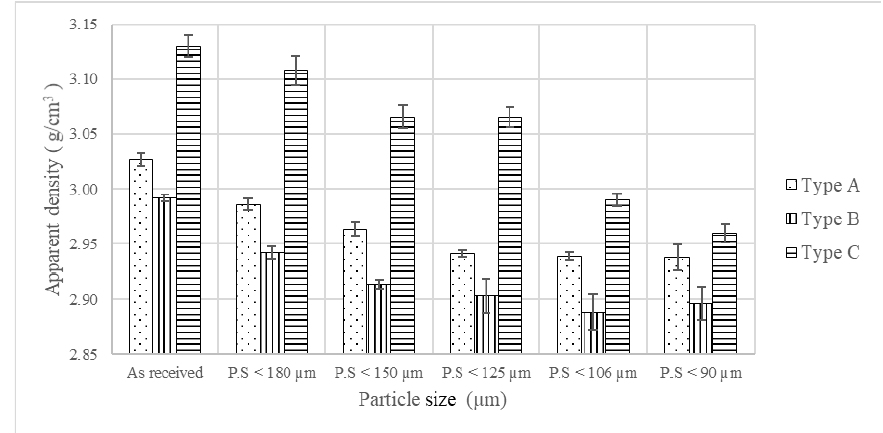
Figure 5. An influence of an incremental cutting-off a heavy tail of the size distribution on the apparent density of pure iron. The notation P.S. < a μ m means that all particles with sizes greater than a μ m were removed.